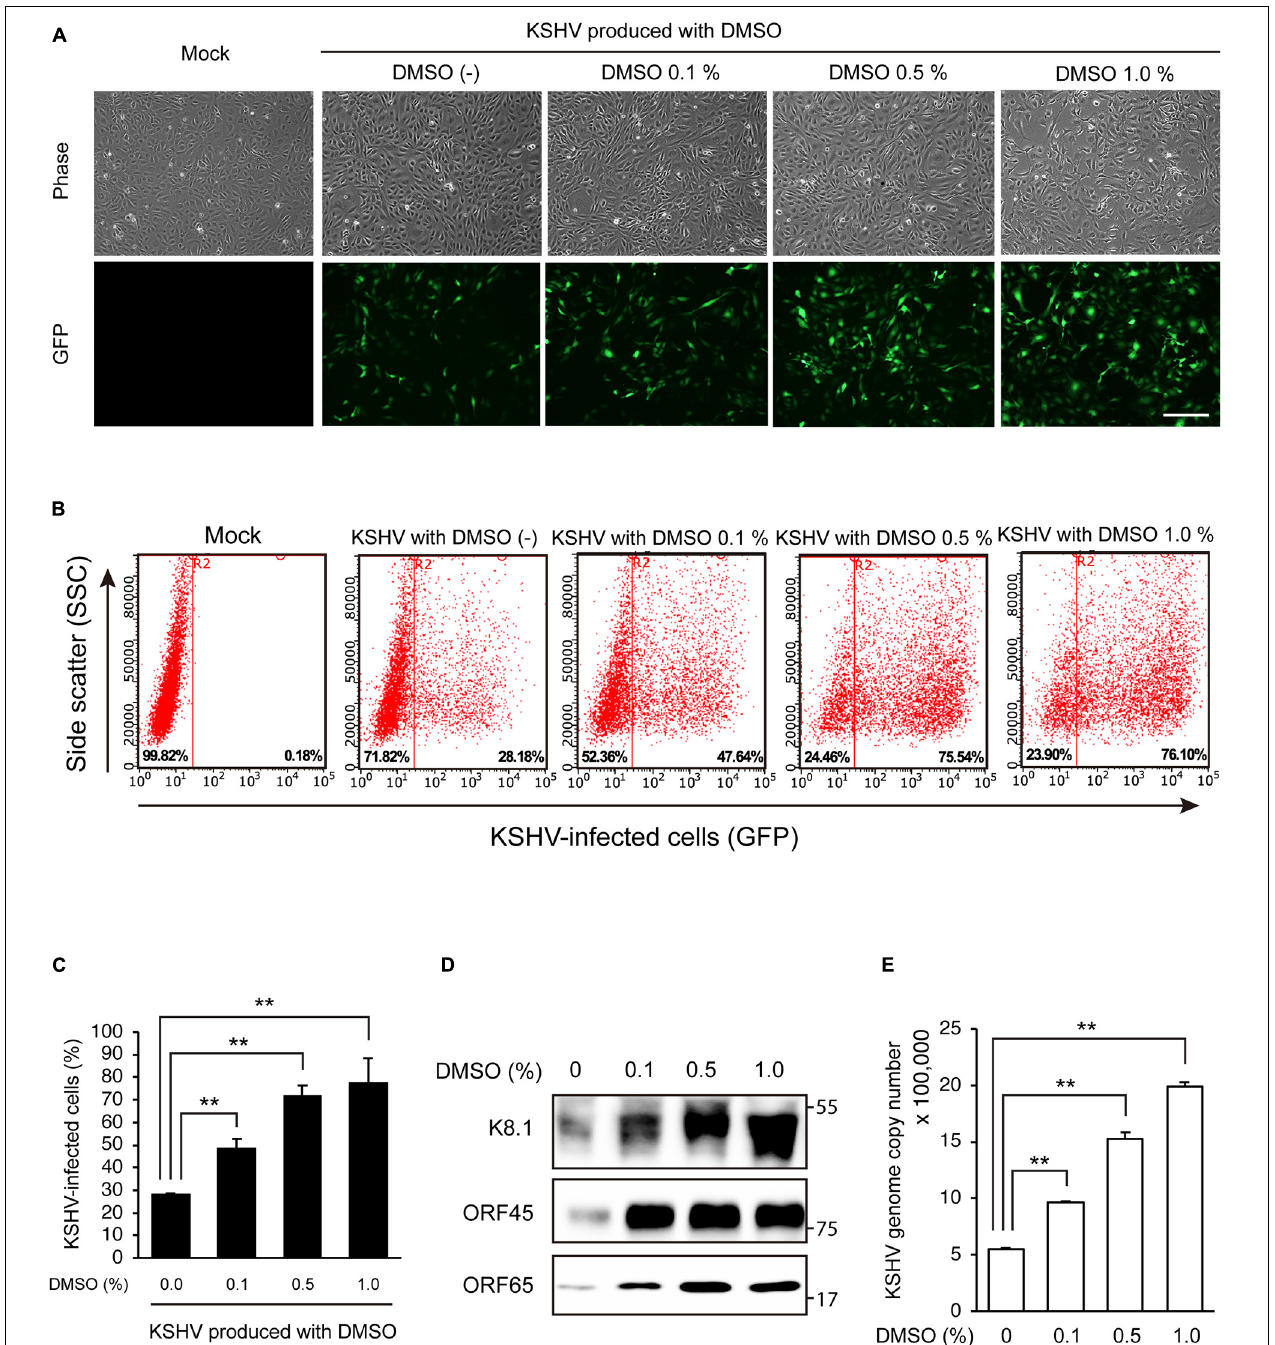
FIGURE 2 | DMSO enhanced KSHV production in iSLK BAC16 cells. KSHV was harvested from iSLK BAC16 cells treated with various concentrations of DMSO during lytic replication. The same volume of KSHV from each group was used to infect HUVECs. (A) GFP expression of KSHV-infected cells in fluorescence microscopy. After 24 h of infection, infectivity was measured by analysis of GFP expression using fluorescence microscopy. Scale bar = 250 µ m. (B) Representative results of the flow cytometric analysis of GFP expression in KSHV-infected HUVECs. KSHV-infected cells from panel (A) were detached and analyzed by flow cytometry. X - and Y -axis indicate GFP expression and side scatter, respectively. The numbers on the right lower corners of each panel indicate the percentage of GFP-positive cells. (C) The flow cytometric analysis of GFP expression in KSHV-infected HUVECs. Data are shown as the mean ± SD, n = 3, ** p < 0.01. (D) Western blot analysis of KSHV proteins of the isolated KSHV from iSLK BAC16 cells. After induction of lytic replication, KSHV was extracted from the supernatants of iSLK BAC16 cells. iSLK BAC16 cells were treated with the indicated concentrations of DMSO during lytic replication. The same volume of extracted KSHV from each experimental condition was analyzed. (E) Analysis of KSHV genome copy numbers from the produced virions. Genomic DNA was isolated from the extracted virions and analyzed by qPCR with specific primers targeting KSHV ORF26 . Data are shown as the mean ± SD, n = 3, ** p < 0.01.